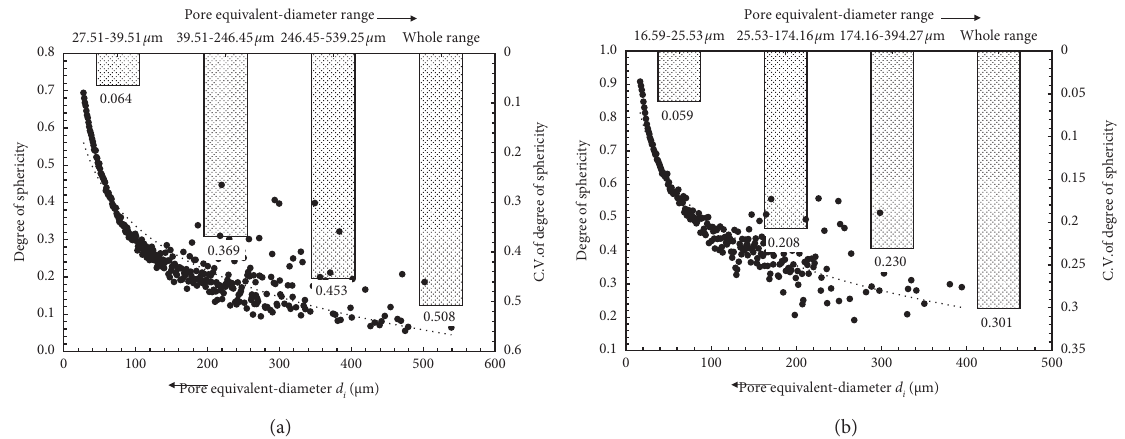
Figure 28: Sphericity distribution and its coefficient of variation of gel-phase of NCG concretion by 3D-XRM. (a) W1 N. (b)